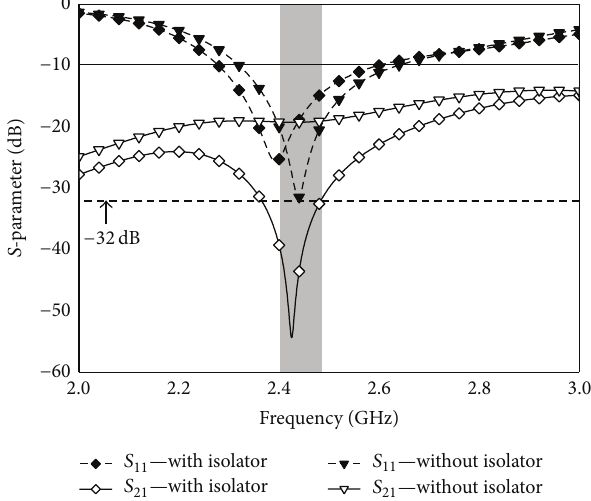
Figure 3: Simulated 𝑆 -parameter characteristics for the proposed antenna with and without